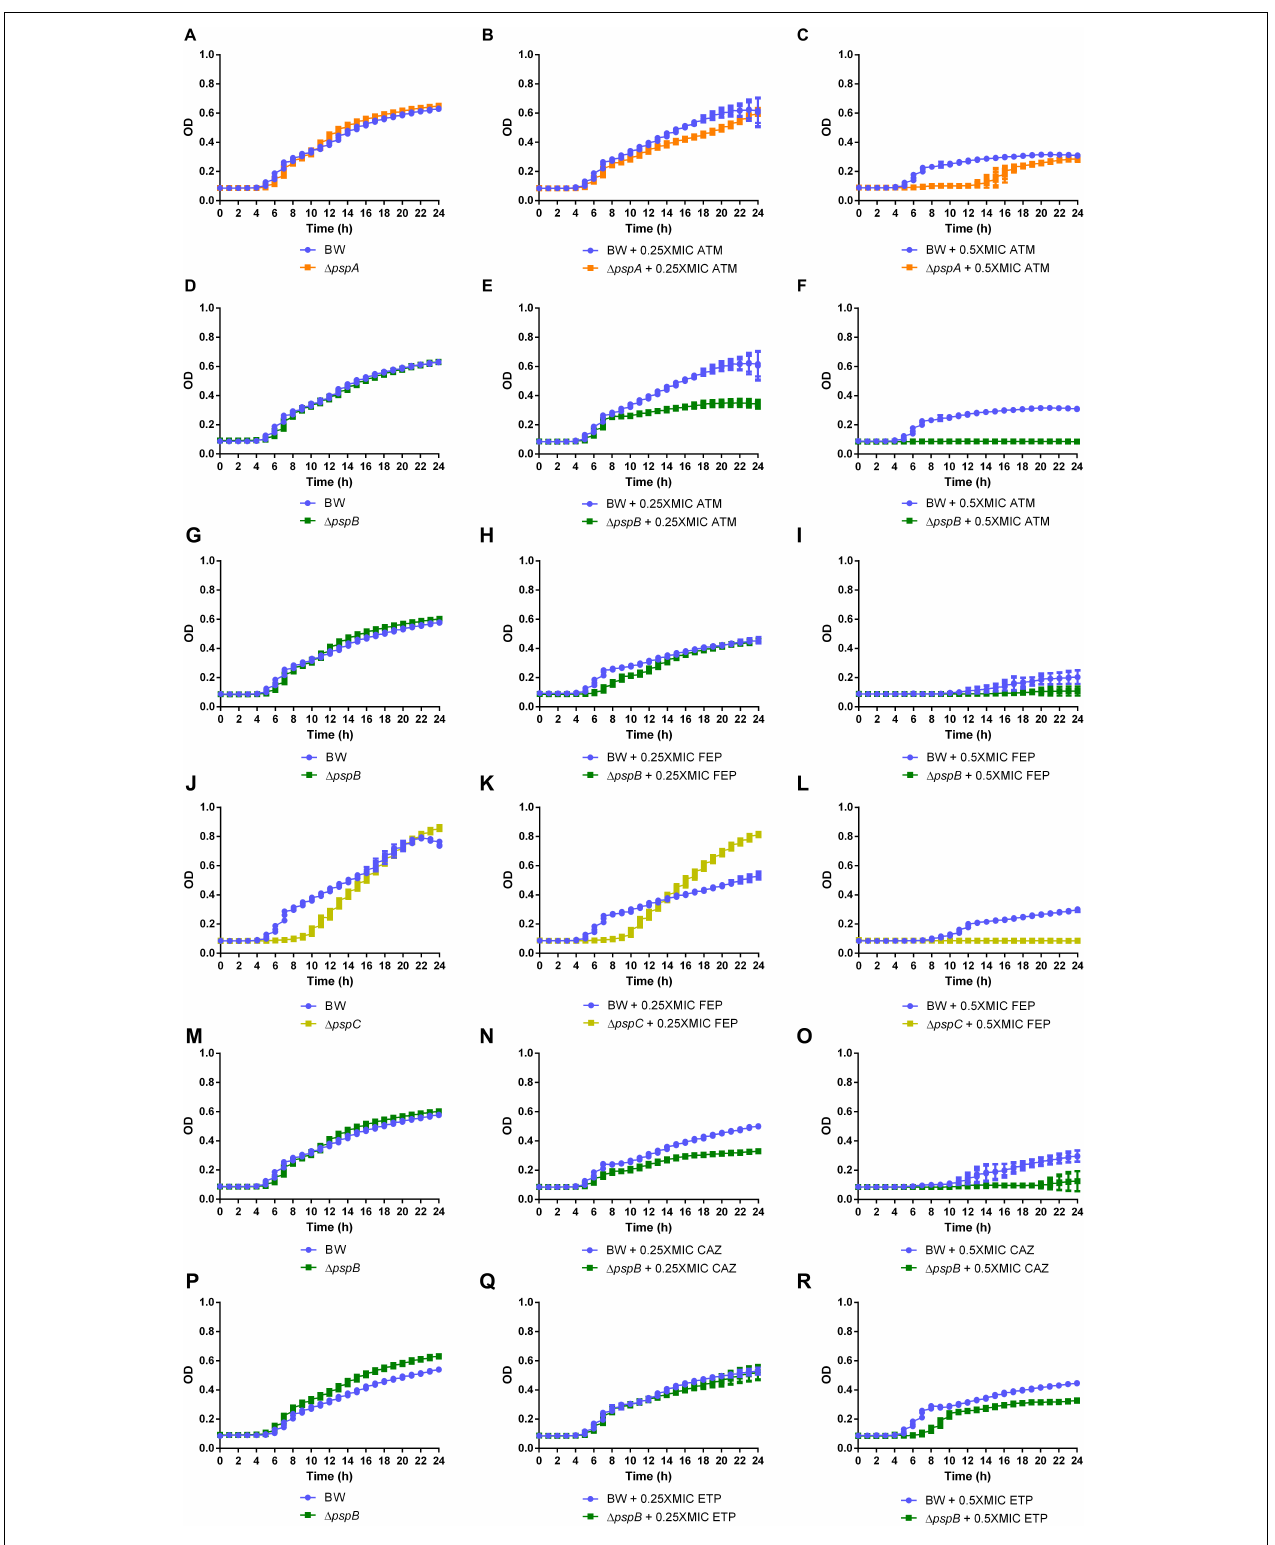
FIGURE 1 | Growth curves in the presence of aztreonam (ATM) for (cid:49) pspA (B,C) and (cid:49) pspB (E,F) mutants, cefepime (FEP) for (cid:49) pspB (H,I) and (cid:49) pspC (K,L) mutants, ceftazidime (CAZ) for (cid:49) pspB (N,O) mutant and ertapenem (ETP) for (cid:49) pspB (Q,R) mutant at concentrations of 0.25xMIC and 0.5xMIC relative to wild-type (BW25113) and their respective controls without antimicrobials (A,D,G,J,M,P) .